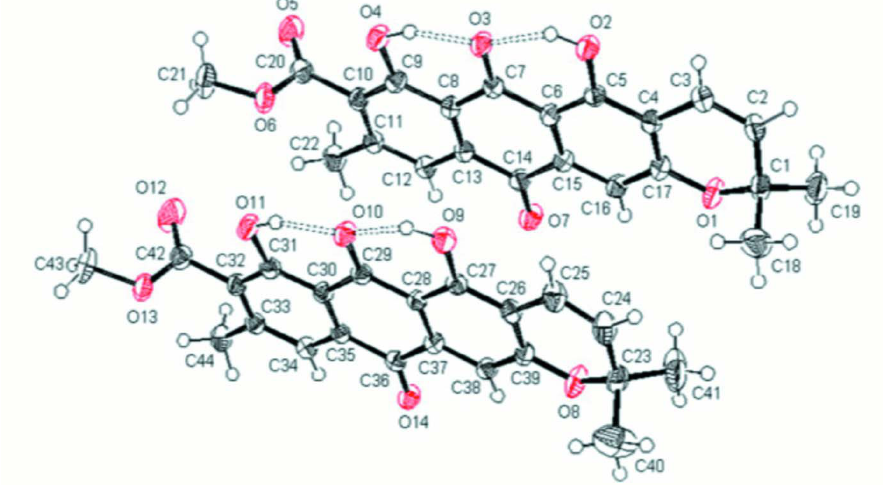
The molecular structure of the title molecule, with the atom-numbering scheme. Displacement ellipsoids are drawn at the 50% probability